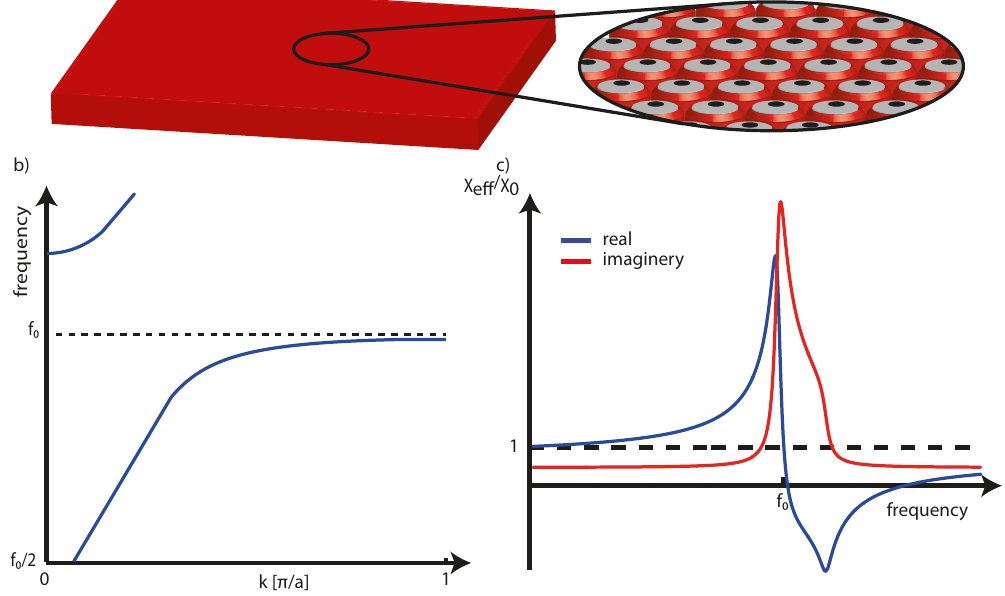
Figure 2. ( a ) The metamaterial made of soda cans can be seen as a homogeneous medium in the long wavelength regime; ( b ) The dispersion relation obtained from the simulated transmission coefficient through a unit cell exhibits the so-called polariton behavior resulting from the avoiding crossing of the free space dispersion relation and the local resonance; ( c ) Description of the dispersion relation in terms of a effective compressibility extracted from the simulations including